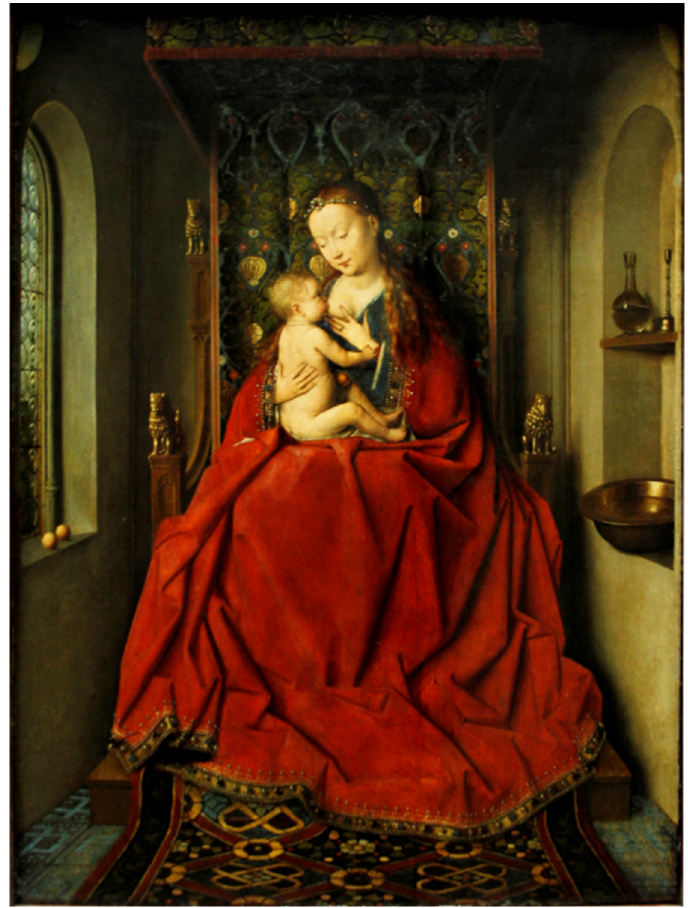
Figure 8. Jan van Eyck, Lucca Madonna , ca. 1437. Mixed technique on oak, 65.7 × 49.6 cm. Frankfurt-am-Main, Städel Museum. © CC BY-SA 4.0 Städel Museum, Frankfurt am Main, https://creativecommons.org/licenses/by-sa/4.0/deed.en (accessed on 30 October 2021). Image in the public domain.